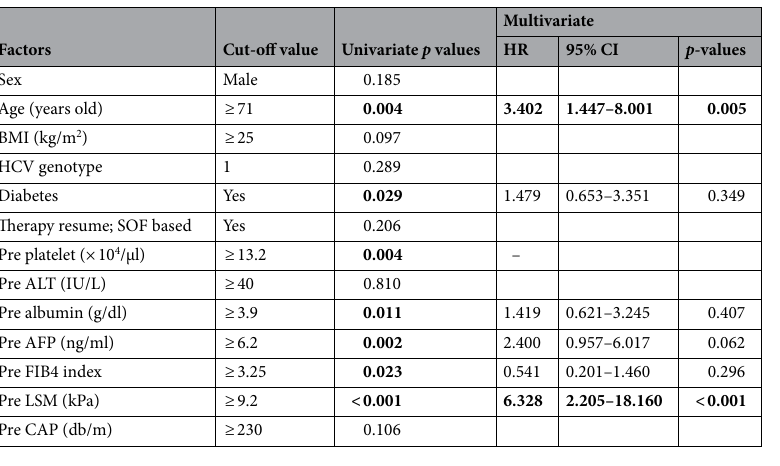
Table 2. Predictive factors at pre-treatment for occurrence of HCC after SVR. BMI Body mass index, HCV Hepatitis C virus, SOF Sofosbuvir, Pre Pre-treatment, AST Aspartate transaminase, ALT